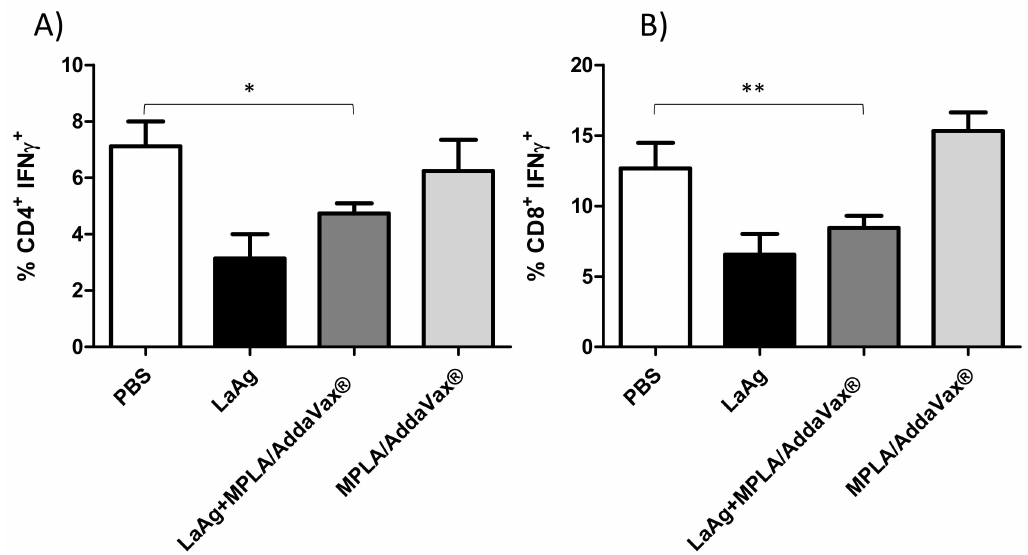
Figure 5. Profile of intracytoplasmic cytokines of CD4 + and CD8 + IFN- γ + T cells. Lymph node cells from mice infected with 2 × 10 5 L. amazonensis promastigotes for 77th days were plated (1 × 10 6 per well) and restimulated for 4 h with phorbol 12-myristate 13-acetate (PMA) (20 ng/mL) and ionomycin (1 µ g/mL), and then stained for flow cytometry analysis. After a previous gate (CD3 + CD4 + ) and (CD3 + CD8 + ), the percentages of CD4 + IFN- γ + T cells ( A ) and CD8 + IFN- γ + T cells ( B ) were determined. The data are representative of one independent experiment (mean ± standard deviation; n = 5) * p <0.05- CD4 + IFN- γ + T cells, ** p < 0.01-CD8 + IFN- γ + T cells, obtained from Student’s